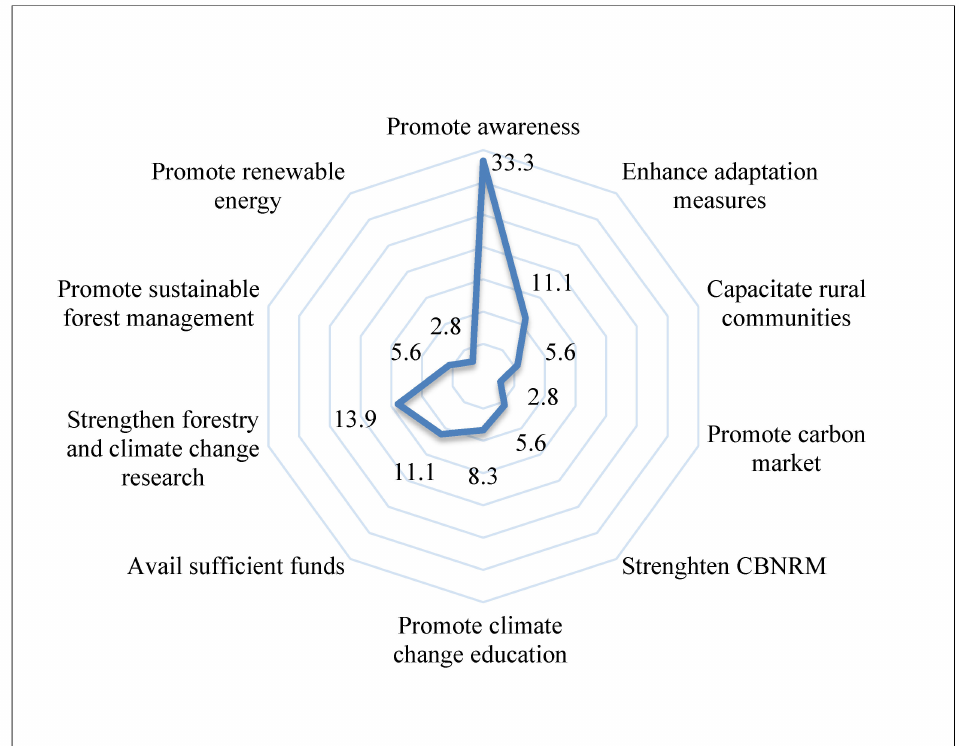
Figure A2. Proposed improvements in the implementation of the NPCC, according to the experts. Proposed improvements for the NPCC are presented as